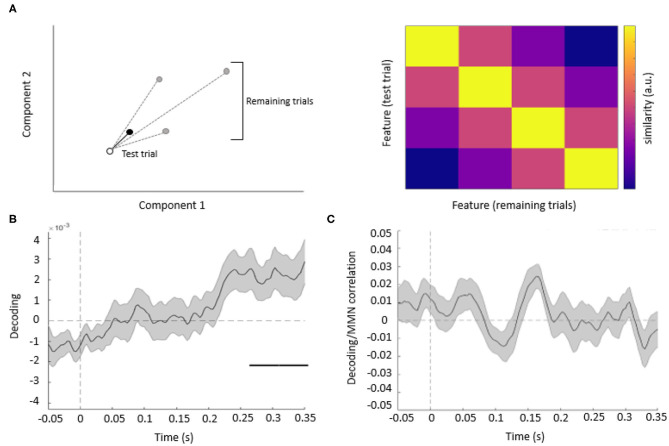
(A) Decoding methods. Left panel: for each trial, we calculated the Mahalanobis distance, based on multiple EEG components (here shown schematically for two components), between the mismatch response in a given (test) trial (empty circle) and the average mismatch responses based on the remaining trials (black circle: same feature as test trial; gray circles: different features). Right panel: after averaging the distance values across all trials, we obtained 4 by 4 similarity matrices between all features, such that high average Mahalanobis distance corresponded to low similarity between features. Based on these matrices, we summarized feature decoding as the difference between the diagonal and off-diagonal terms. (B) Multivariate analysis. The average time course of the decoding of acoustic features based on single-trial mismatch response. The gray-shaded area denotes the SEM across participants, and the horizontal bar (black) shows the significant time window. (C) Decoding vs. MMN correlation analysis. Plot shows the time-series of mean correlation coefficients between single-trial decoding estimates and single-trial MMN amplitudes, calculated for Cz/Cpz channels and averaged across participants (shaded areas: SEM across participants). No significant correlations were observed when correcting for multiple comparisons across channels and time points.